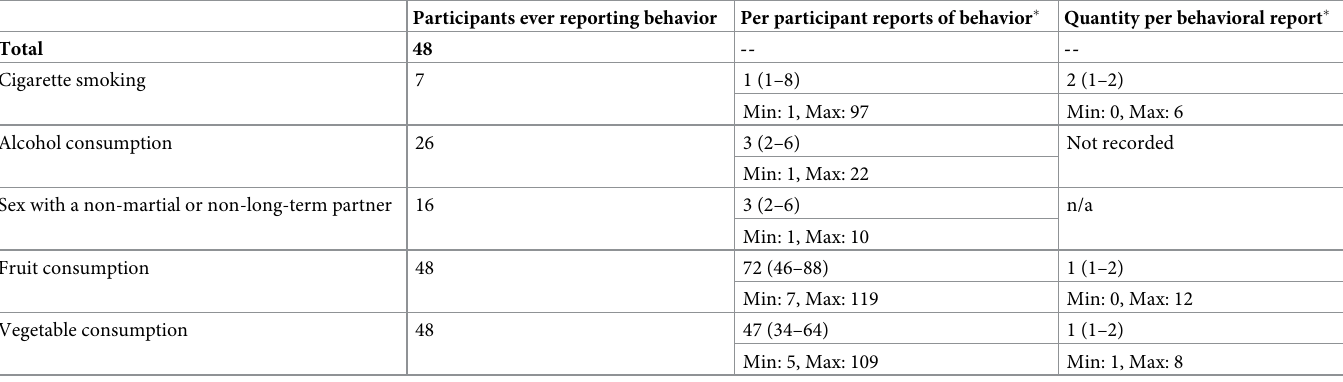
Table 3. Behaviors reported in response to twice-daily prompts.